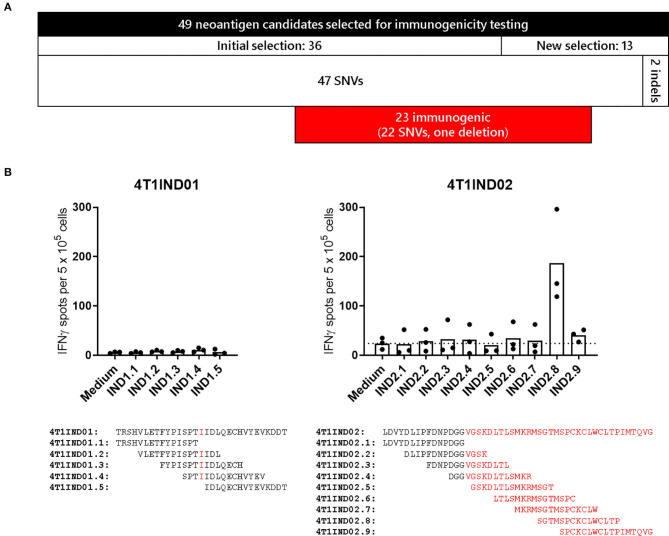
(A) Numerical overview of selected neoantigen candidates for immunogenicity testing. 22 out of 49 assessed targets were immunogenic. (B) Immunogenicity testing of indels. Splenocytes of immunized mice (n = 3 per indel) were tested 5 days after the last immunization via IFN-γ ELISpot for recognition of overlapping 15-mer peptides covering the complete 4T1IND01 and 4T1IND02 sequence as indicated below the graphs (11 amino acid overlap, new amino acids are highlighted in red). Columns indicate mean of spot counts. Peptide IND2.8 elicited IFN-γ spots >2-fold over background (dotted line, medium control).